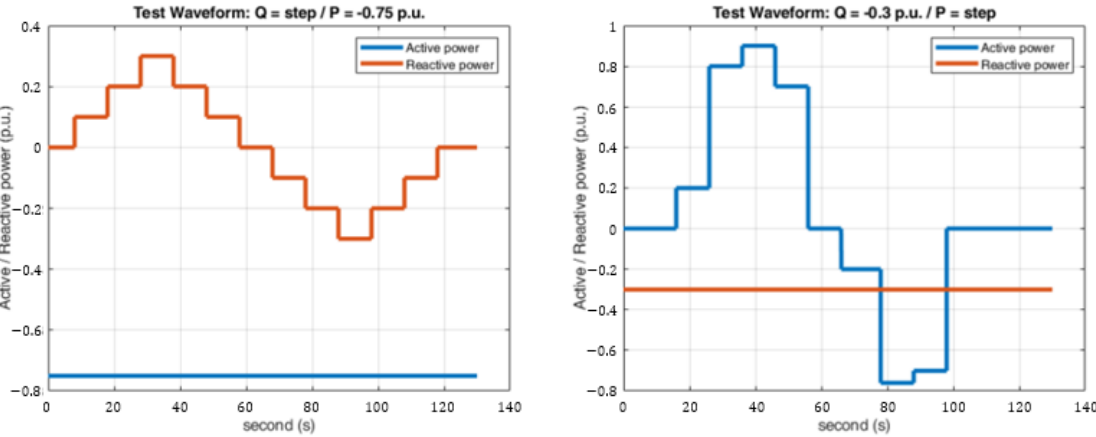
Figure 19. The parameter applicability evaluation waveforms . 4.5. Universal Model Simulation Results of an Energy Storage System with the Optimization Algorithm The fitting parts of three simulation waveforms are shown in Figures